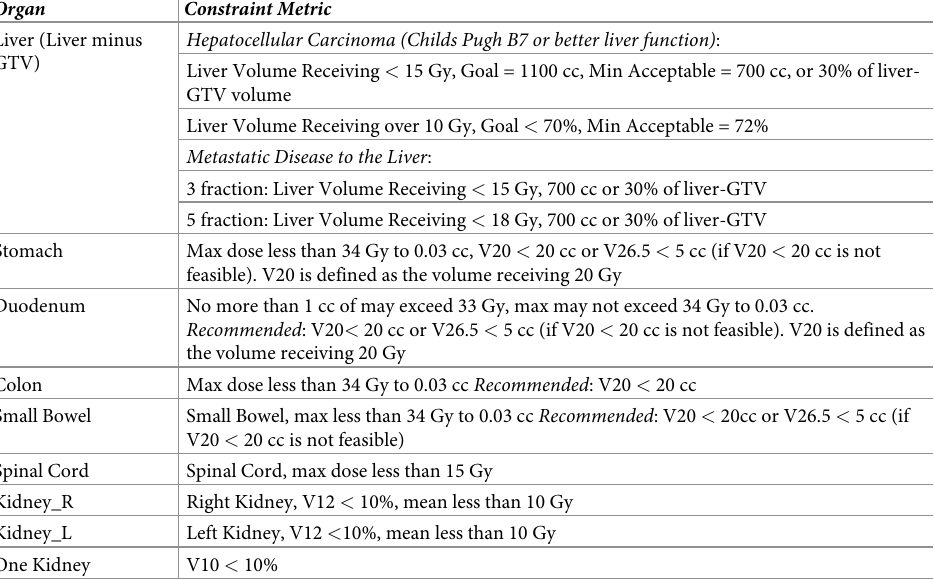
Table 3. Dose constraints used for SBRT for abdominal metastatic lesions or primary hepatocellular carcinoma, DVH Criteria, 5 fraction